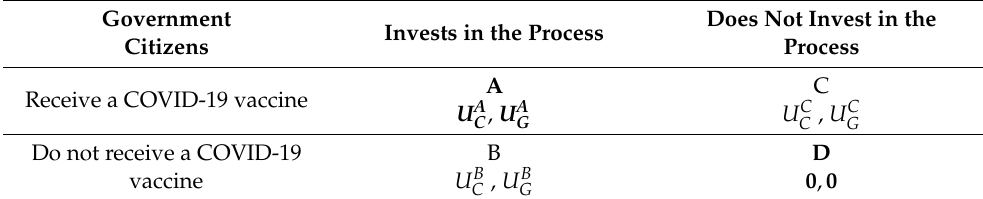
Table 3. The game